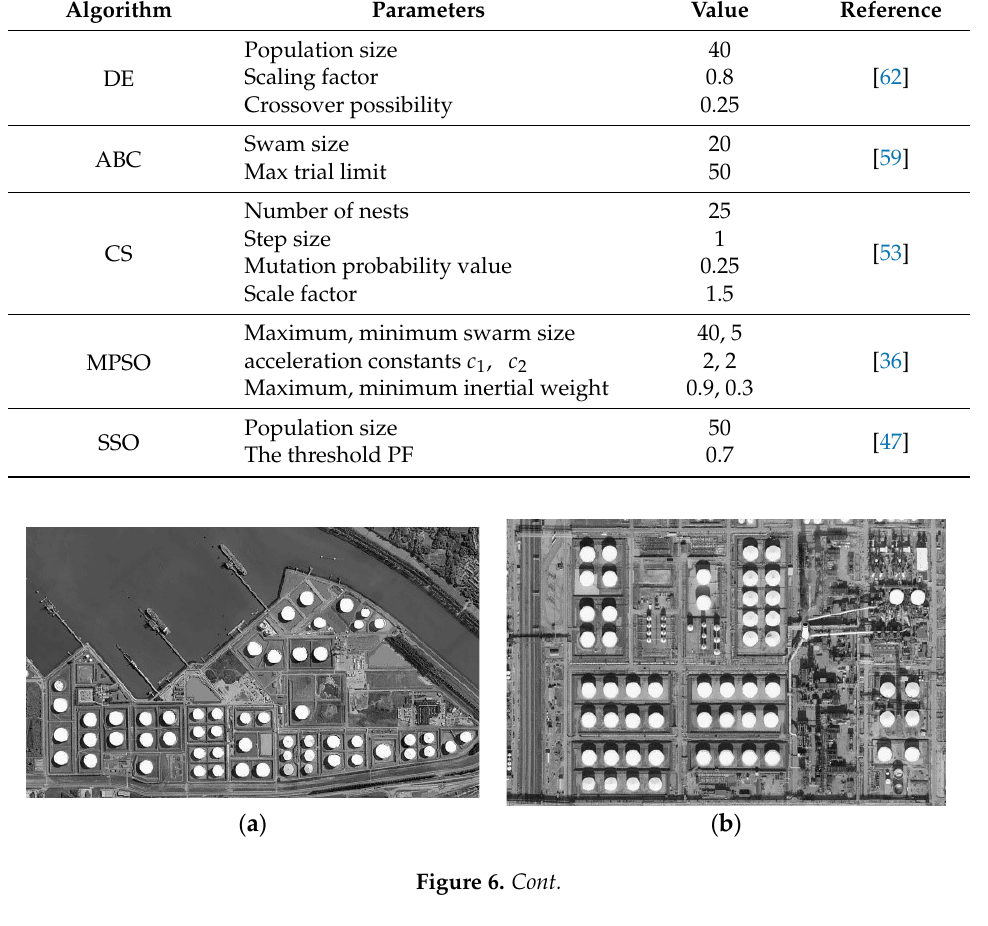
Table 6. Parameters and references of the algorithms.